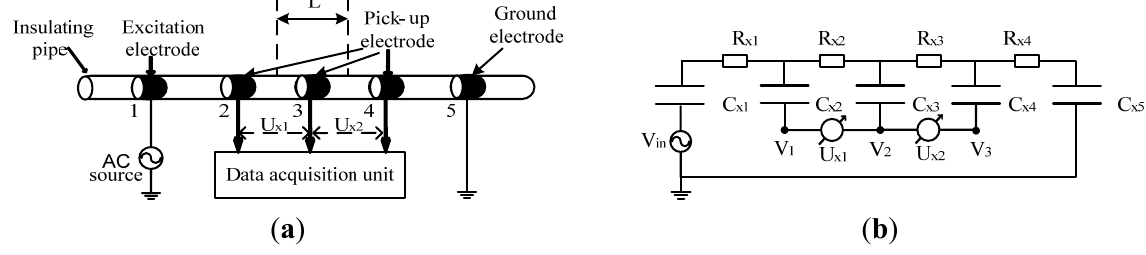
Figure 2. The new five-electrode C 4 D sensor. ( a ) The construction of five-electrode C 4 D sensor; ( b ) The simplified equivalent